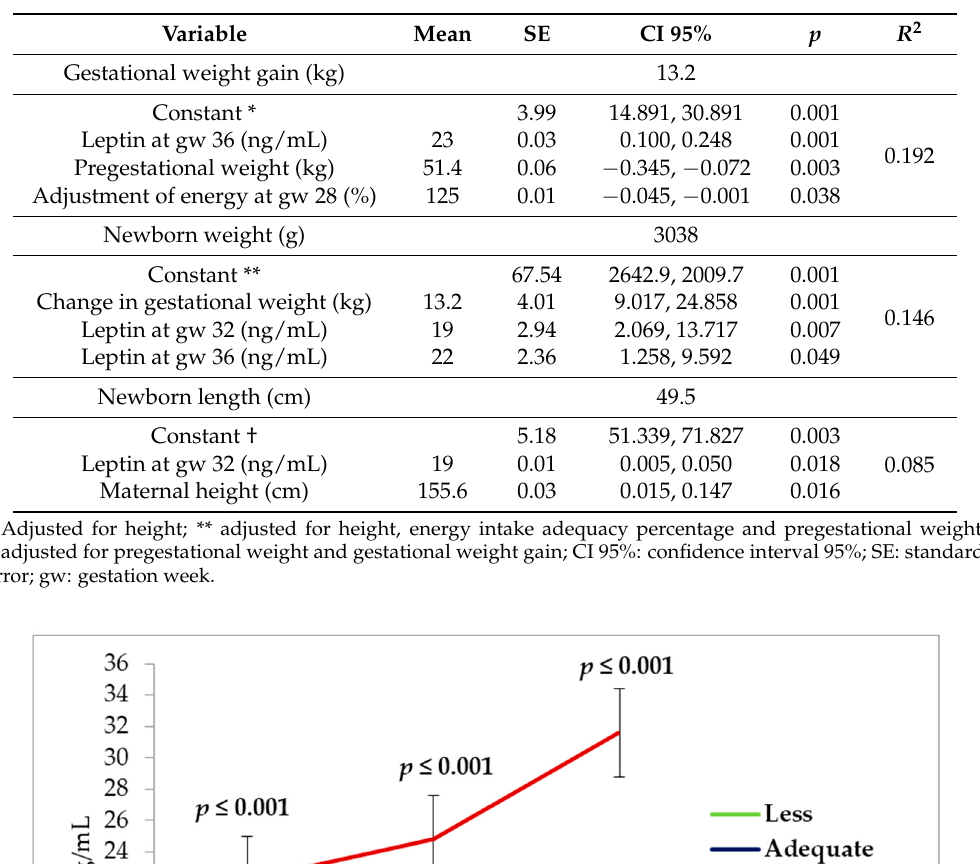
Table 3. Models of linear regression that explain the change in maternal gestational weight and the weight and length of the newborn.